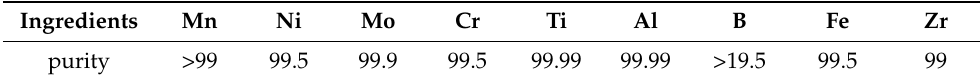
Table 2. Mass fraction of test powder (mass, wt%).